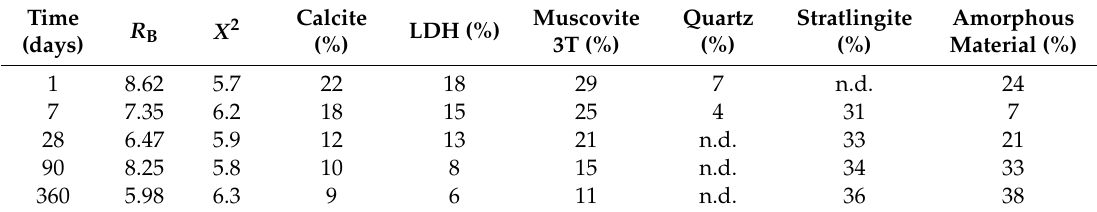
Table 6. Rietveld quantification in kaolin / lime systems at 750 ◦ C / 2 h.